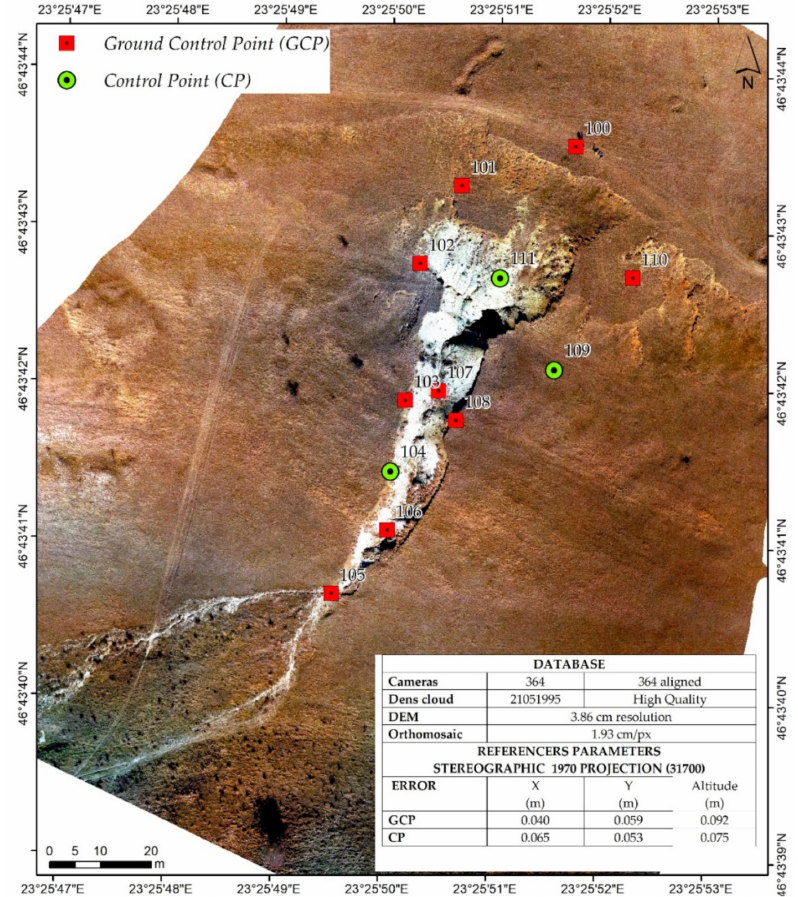
Figure 4. GCP and CP location inside the study area; obtained